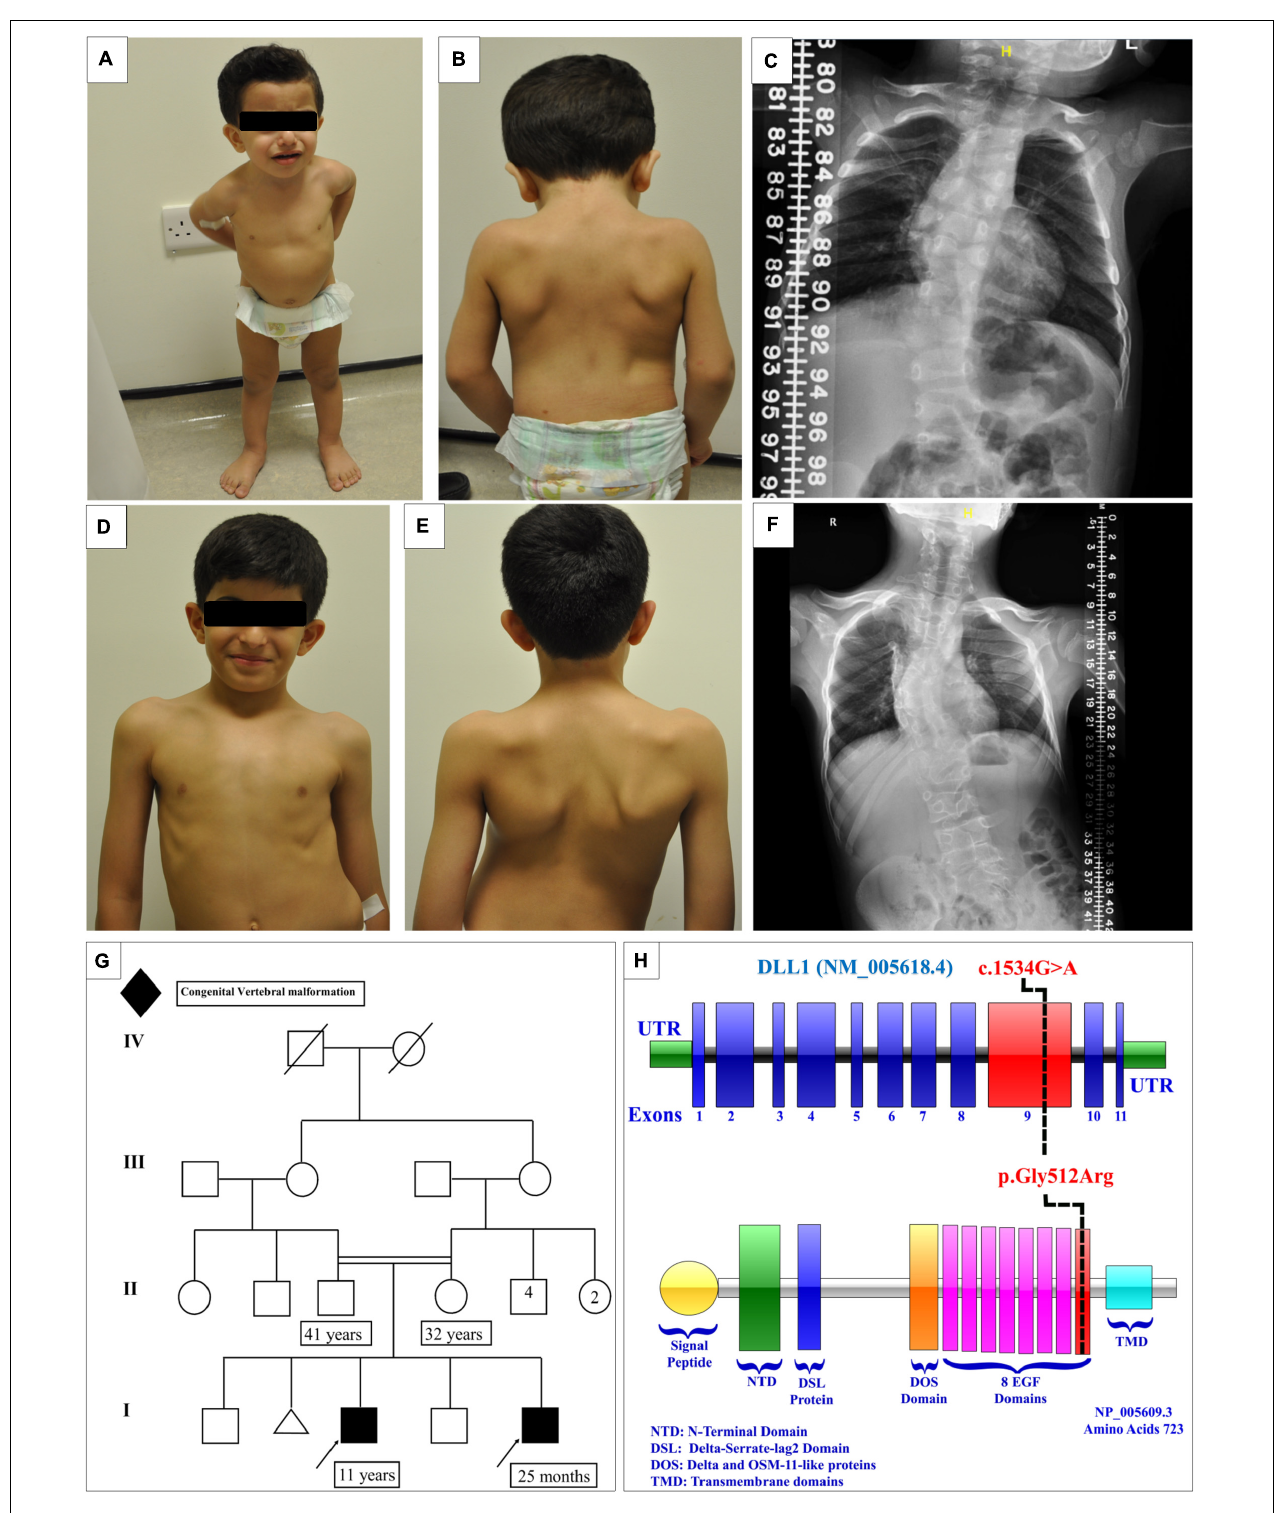
FIGURE 2 | Clinical features of the affected siblings. (A,B) Clinical features of patient 1. (C) The latest scoliosis survey for patient 1. (D,E) Clinical features of patient 2. (F) The latest scoliosis survey for patient 2. (G) Family pedigree. (H) DLL1 gene and protein showing the site of the identified variant in the epidermal growth factor-like (EGF) domain